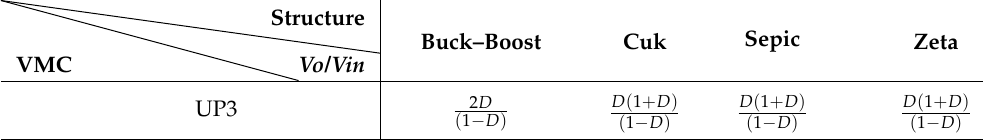
Figure 21. S witched inductors. ( a ) [37]. ( b ) [42]. ( c ) [43]. ( d,e ) [44].